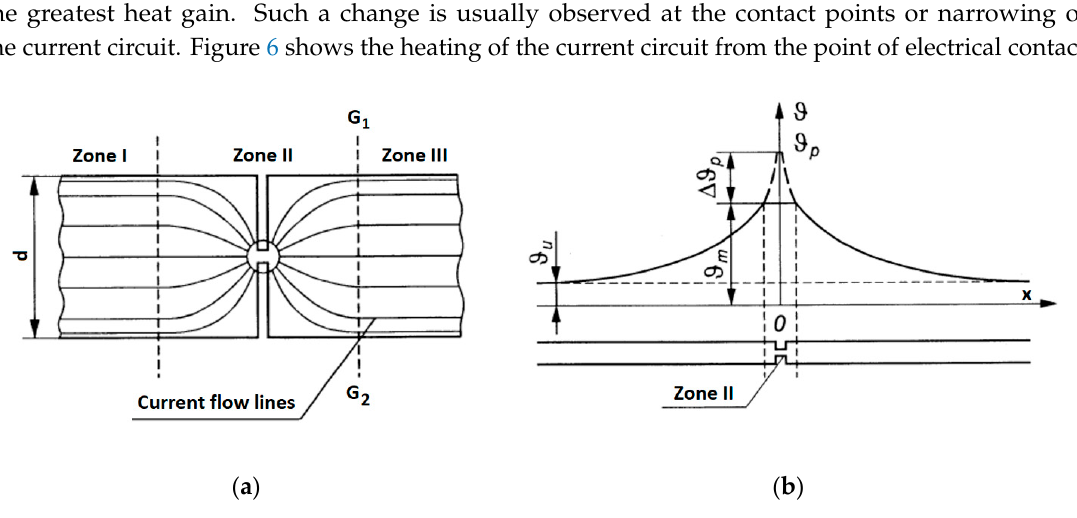
Figure6. Heatingofthecurrentcircuitwithasinglepointcontact: ( a )Contactmodeland( b )temperature Figure 6. Heating of the current circuit with a single point contact: ( a ) Contact model and ( b ) distribution along the current path, where ˘υ —maximum temperature present at the contact point. temperature distribution along the current path, where ῠ —maximum temperature present at the contact point.